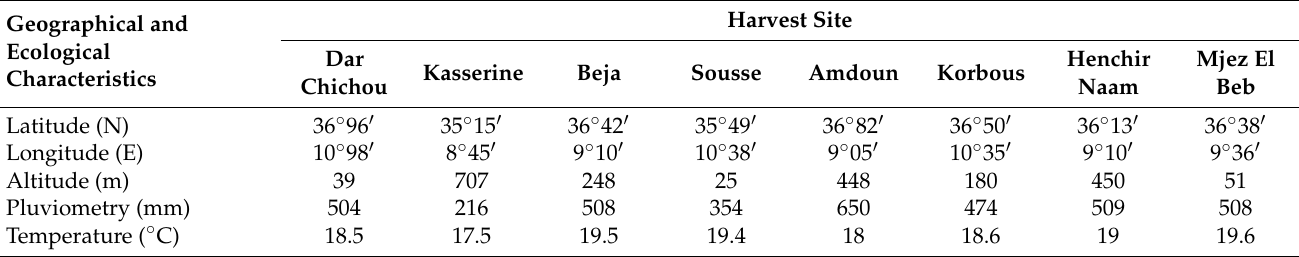
Table 1. Geographical coordinates and ecological characteristics (latitude, longitude, altitude, biocli- mate, Pluviometry, temperature) of the plant material harvesting